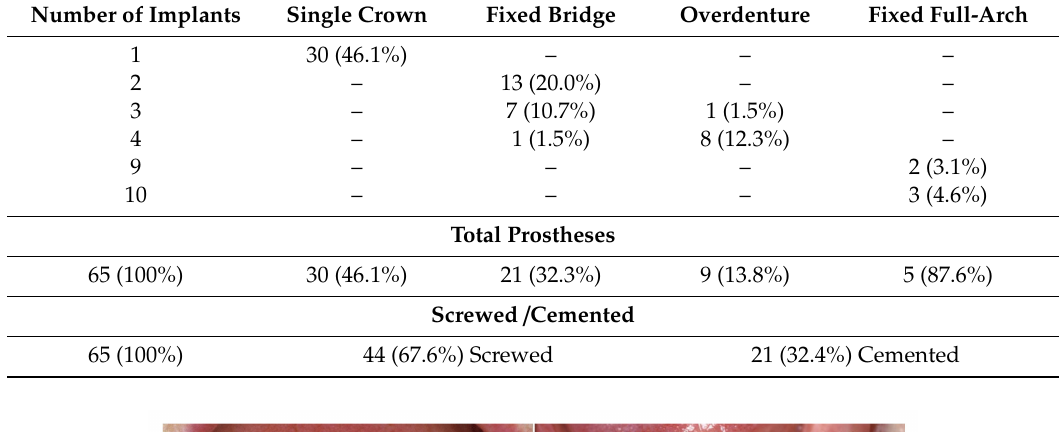
Table 3. Description of the prosthesis type distribution with the number of implants used to support them and the percentage of screwed and cemented prosthesis.